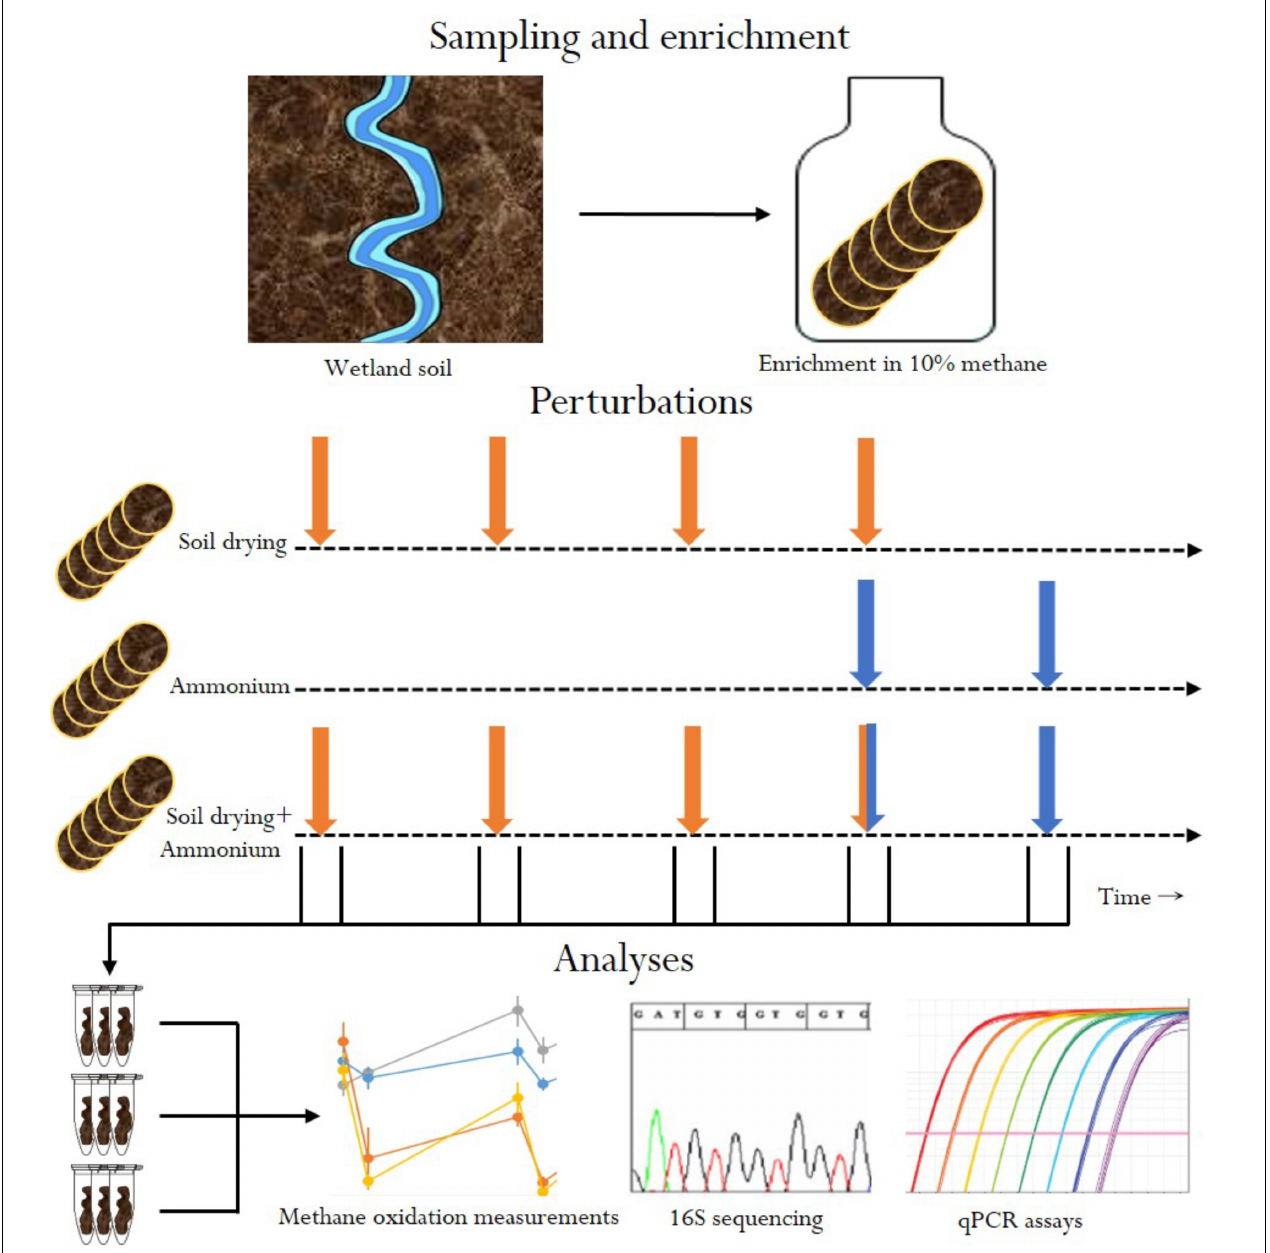
FIGURE 1 | Overview of experimental design. Orange arrows indicate soil drying events. Blue arrows indicate ammonium